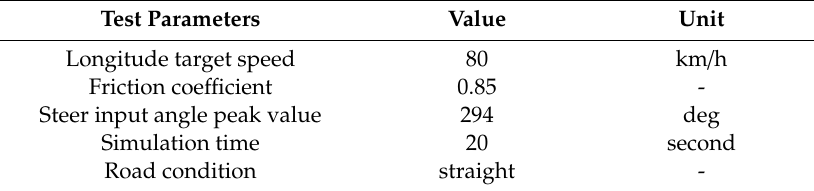
Table 11. Main parameters of fishhook test.